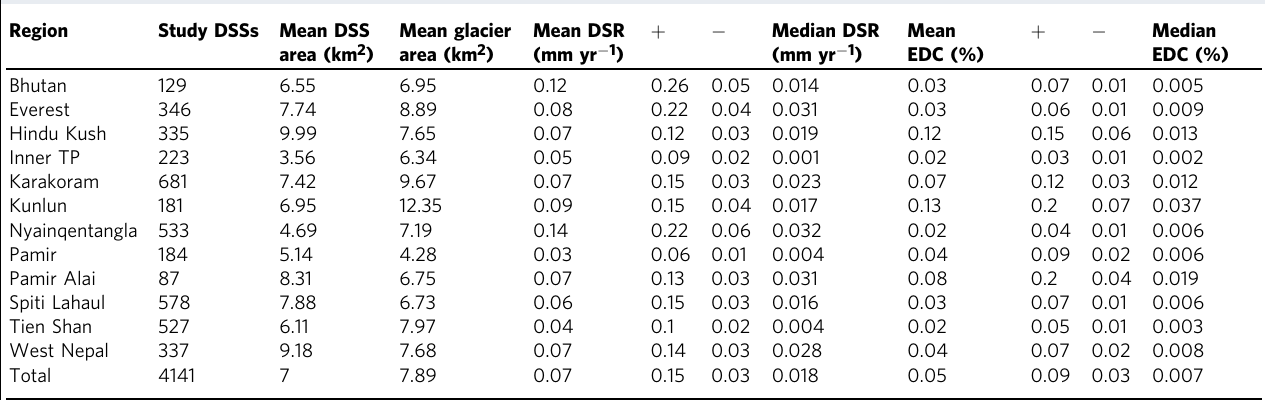
Mean and median debris-supply rate are weighted by debris-supply-slope area. Mean and median EDC are weighted by glacier volume. DSS is debris-supply slope. + and − are one-sigmauncertainties.